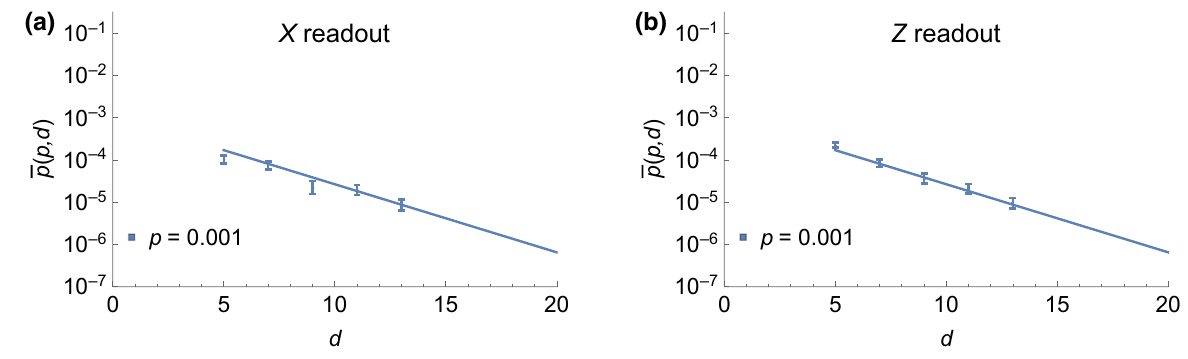
FIG. 19. Readout failure probability for X and Z . Note the value is orders of magnitude lower than for the other logical operations and that we show only that for p = 0.001, since the smaller values of p are so low that they are difficult to observe using Monte Carlo. We use the ansatz in Eq. (7) to extract the parameters for p